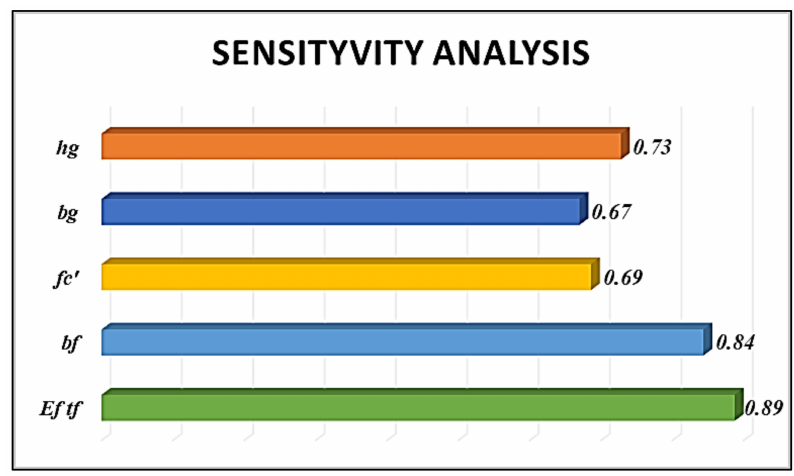
Figure 4. Sensitivity analysis of input parameters to output parameters.